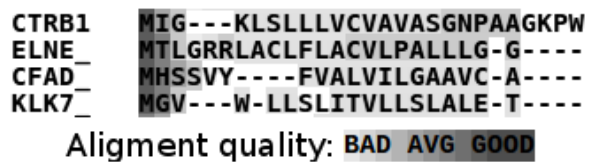
Figure 1: MSA: Multiple Sequence alignment example.